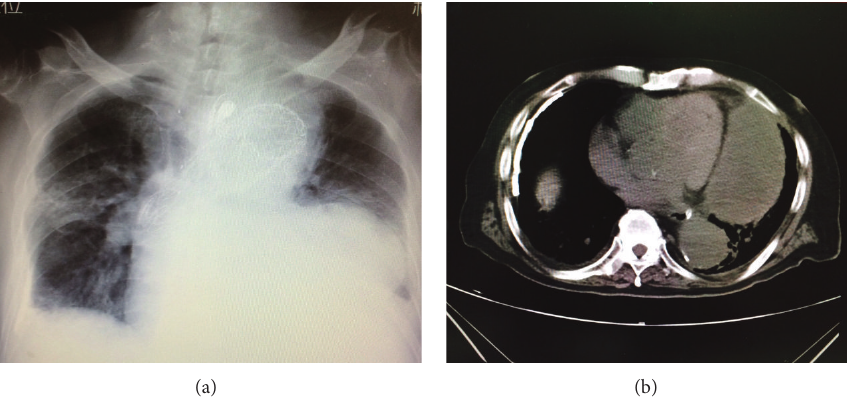
Figure 3: (a) Plain radiograph taken at postoperative day 25. (b) Image from plain CT performed at postoperative day 20. Resorption of the hematoma had progressed, and its size had decreased. The findings revealed that hemostasis was achieved as a result of TEVAR and that the patient’s condition tended to